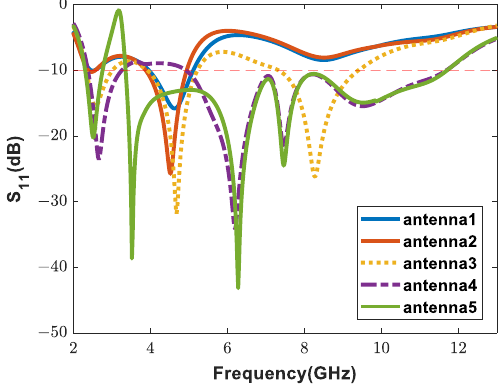
Figure 3. S-parameter simulation for each step of the design.